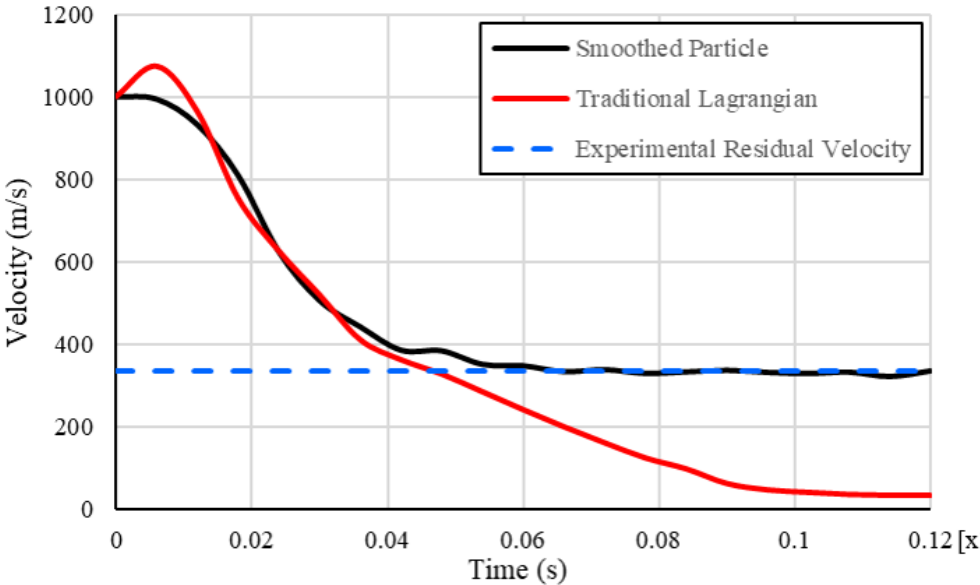
Figure 12. Comparison of Projectile Residual Velocity between Traditional Lagrangian Finite Element and Smoothed Particle Hydrodynamics